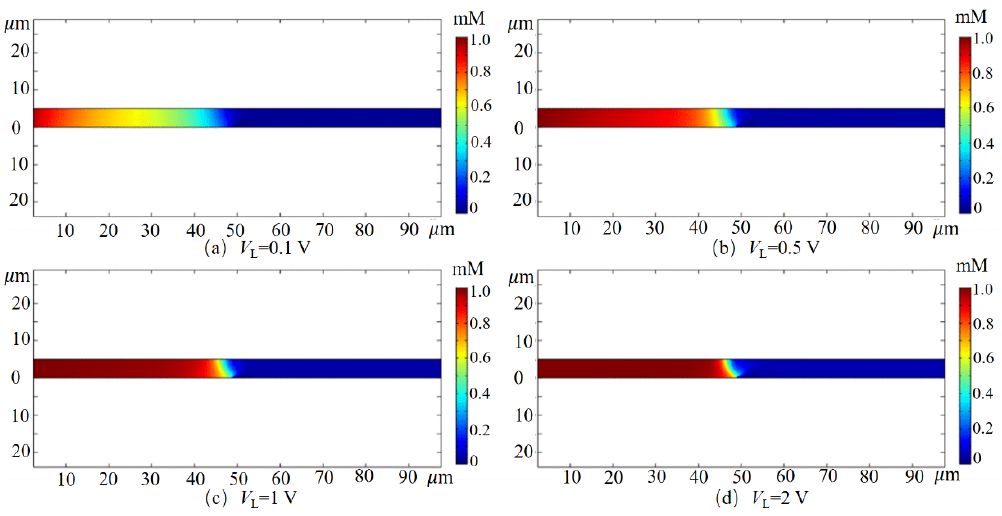
Figure 3. The concentration distribution of Cl (cid:2879) in the channel at different inlet potentials at (cid:1848) (cid:3030)(cid:3040) = 400 mV.